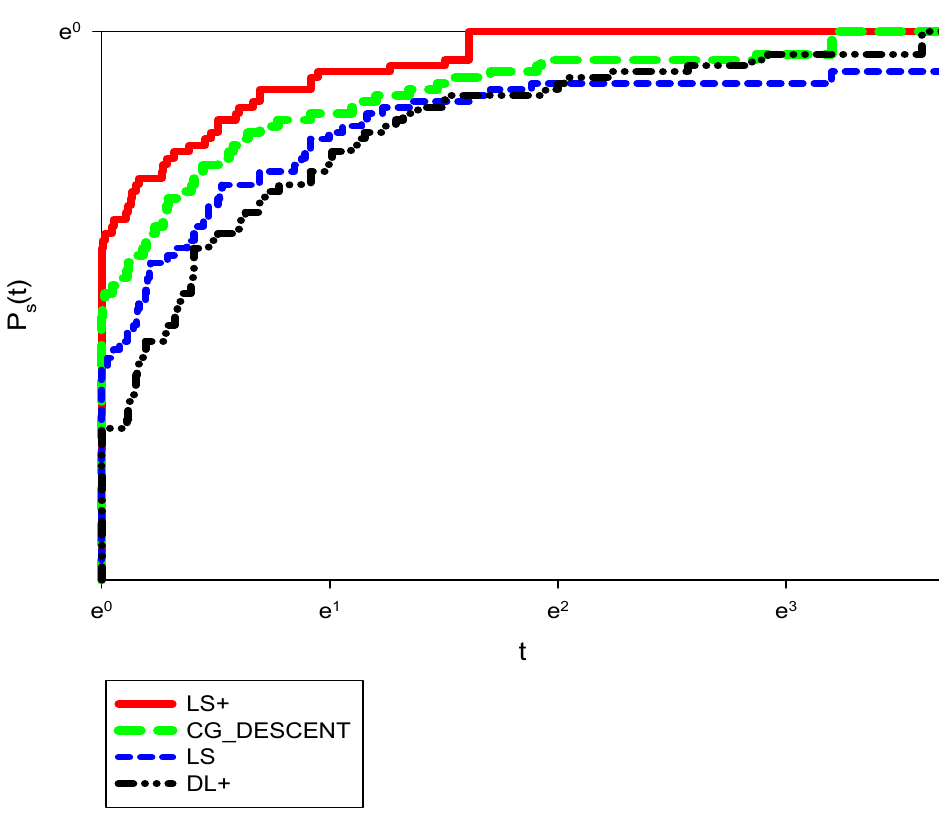
Figure 1. Performance measure based on the number of iterations.